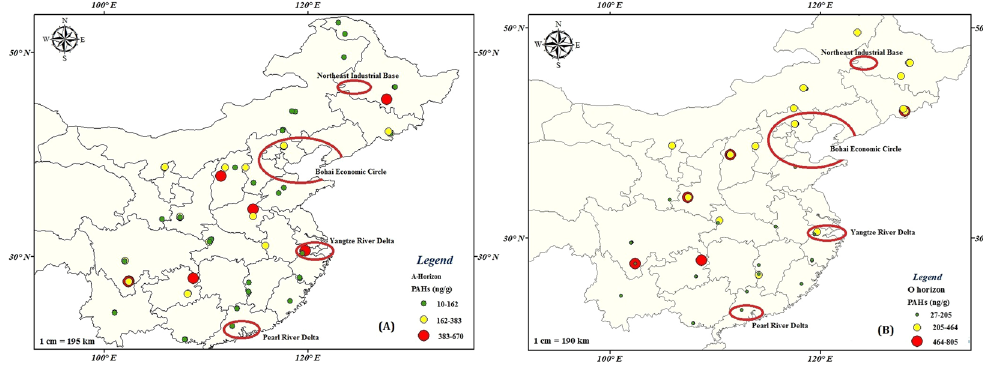
Figure 1. Geographical distribution of total PAHs (ng/g.dw) in soils ( A ) A-Horizon & ( B ) O-horizons across Chinese forests. (The background map was made using ArcGIS 9.3 by one